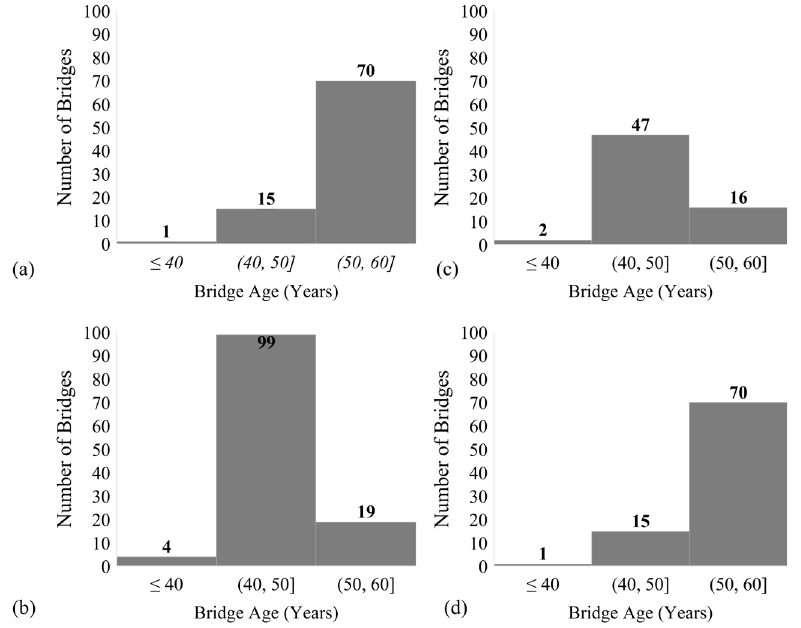
Figure 8. Operating rating vs. year built/reconstructed (Note: 1 kip = 4.4482 kN). The design vehicle used in this study is a HL-93 truck, which has a GVW of 80 kips (355.86 kN) as indicated as a horizontal line in Figure 8. Some bridges at WIM site 0210378 on the I-75 route have a capacity less than 80 kips (355.86 kN) and were constructed before 1980. Some bridges have a capacity as low as 50 kips (222.41 kN) even after reconstruc- tion. In Figure 9, bridges with a low reliability (RI < 2.0) are presented by age groups in each route.